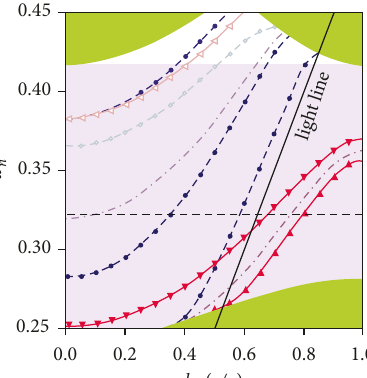
Figure 2: (Color online) projected BSs of the IWG for d (light blue-colored dashed line with hollow circles) and d IWG 4 . 0 a (purple-colored dashed lines with filled circles), as well as a single PC surface terminated with annular scatterers (magenta- colored dash-dotted lines) and two identical surfaces in proximity (solid lines with triangles where the red-colored filled and the pink- colored empty triangles represent the surface and WG bands, respectively). Inside the PBG, WG bands lie above the light line, while surface bands lie below the light line. The solid shaded areas are the bulk bands, whereas the graded rectangular area represents the full TM PBG. The horizontal thick dash-dotted line (black- colored) indicates the wavelength of interest, i.e., λ 0